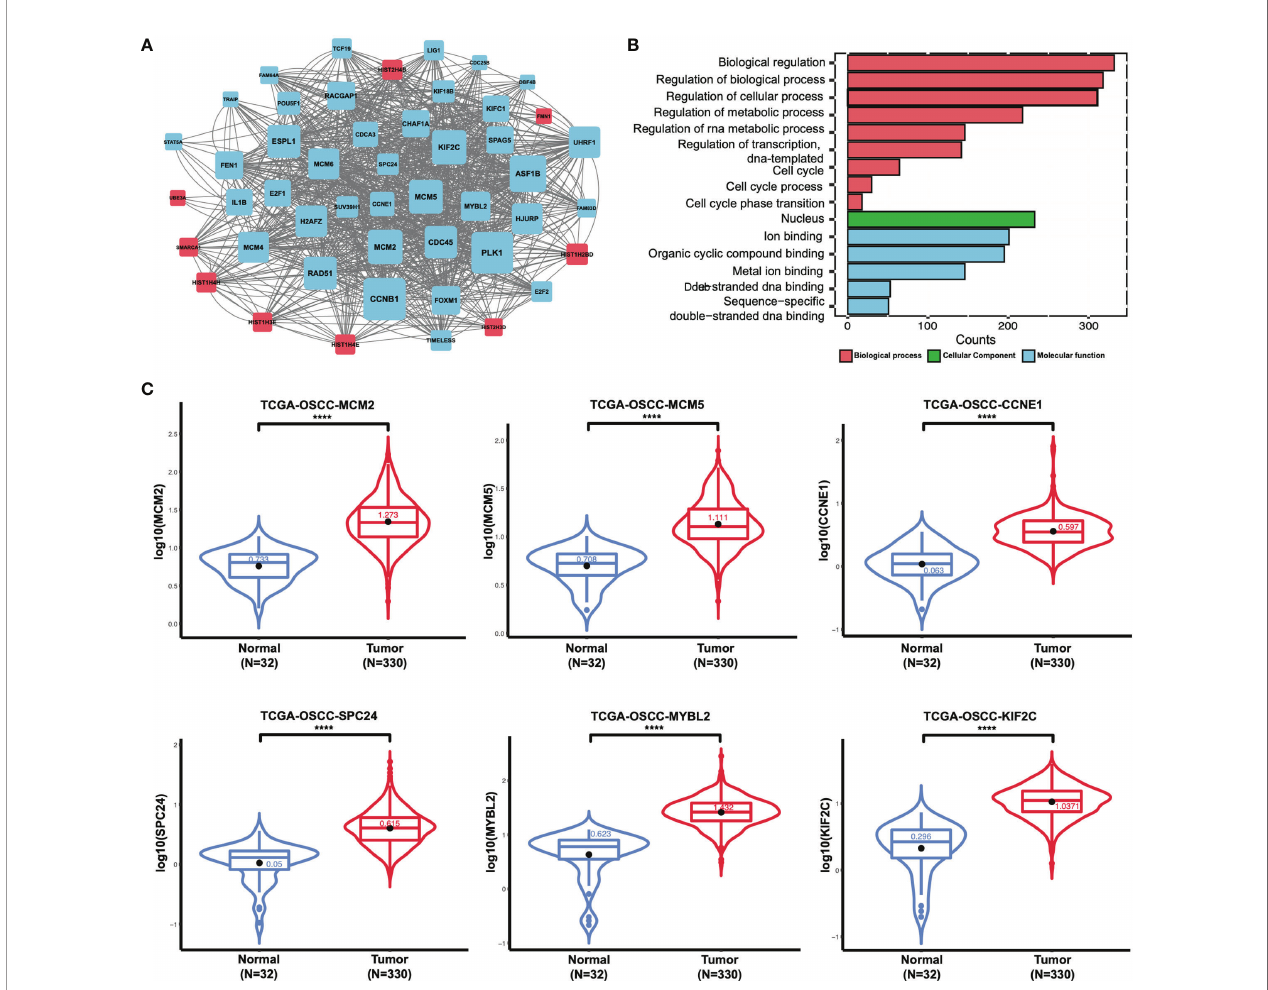
FIGURE 7 | Results of the RNA sequencing analysis and validation of DEGs. (A) Protein – protein interactive network of DEGs with nodes >19 and their related proteins. The different sizes of the nodes represented the degree of the node speci fi c in the PPI network. Blue nodes mean downregulation level while red nodes represent upregulation level. (B) Enriched GO terms of DEGs (BP, CC, and MF). (C) MCM2, MCM5, CCNE1 SPC24, MYBL2, and KIF2C mRNA expression status between normal tissues and tumor tissues in OSCC from TCGA (boxplot and violin plot). ****P <